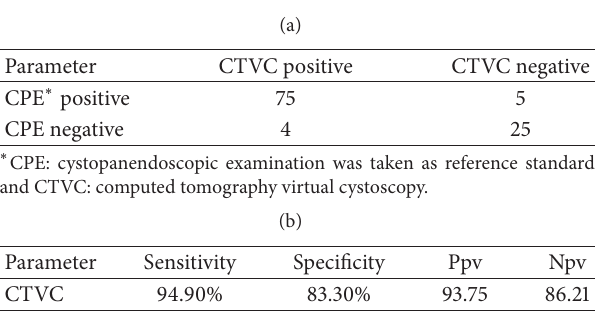
Table 2: (a) Number of tumors detected in patients: taking CPE as reference standard, out of 80 tumors detected on CPE, CTVC was able to detect 75 tumors accurately while five tumors were missed. Four tumors were falsely detected as positive on CTVC which were actually not present on CPE. (b) Depicting the sensitivity and specificity of CTVC in patients with respect to number of tumors detected.